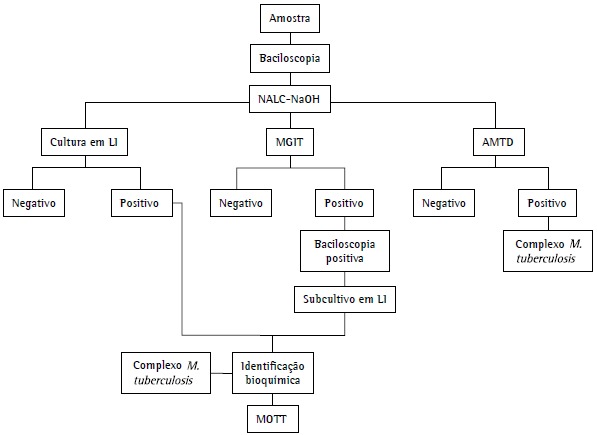
Fluxo de processamento das amostras. NALC-NaOH:
N-acetil-L-cisteína-hidróxido de sódio; LJ: Löwenstein-Jensen; MGIT:
Mycobacteria Growth Indicator Tube; AMTD: teste amplified Mycobacterium
tuberculosis direct; e MOTT: mycobacteria other than tuberculosis
(micobactérias que não tuberculose).